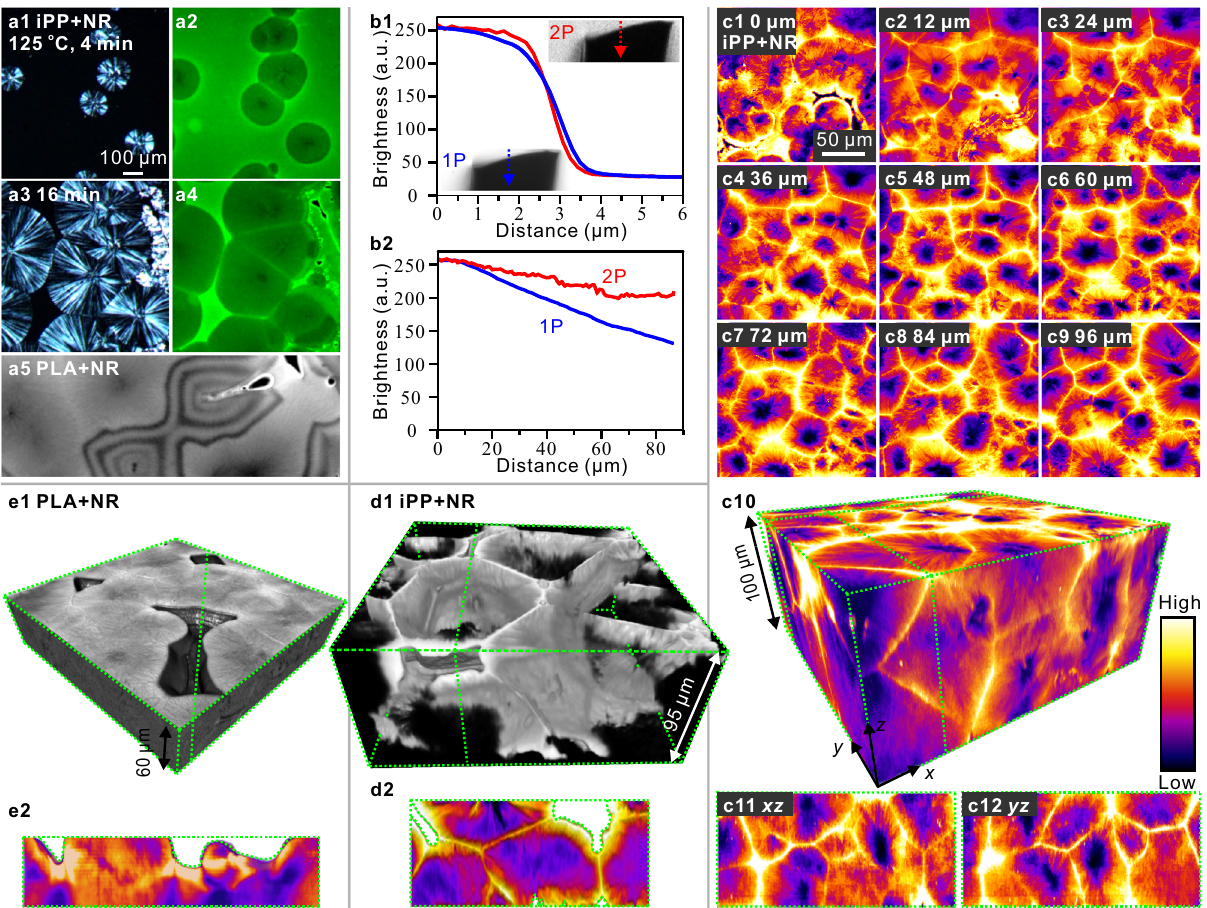
Fig. 1 2D and 3D fl uorescence microscopy of fl uorophore-labeled polymers after complete isothermal crystallization showing internal and surface structure. a1 - a4 , 2D micrographs of ∼ 10 µ m thick fi lm of iPP doped with 0.05 wt % Nile Red during isothermal crystallization at 125 °C: ( a1 , a3 ) cross- polarized and ( a2 , a4 ) FM; the dye is seen to be partially rejected from the growing spherulites. a5 FM of fully crystallized PLA; cavitation and Newton interference contours are seen. b Comparison of 1-photon and 2-photon confocal microscopies: (b1) z- scans across a sharp end of a glass fi ber embedded in NR-doped polystyrene (PS) — blue = 1-photon, red = 2-photon; (b2) 1-photon (blue), and 2-photon (red) fl uorescence intensity vs . depth in a sheet of NR-doped PS illuminated by 543 nm and 1000 nm lasers, respectively. c NR-labeled iPP crystallized at 120 °C: ( c1 – c9 ) selected z- slices as recorded by 2-photon microscopy, bottom to top, using false-color scale at the bottom right; (c10) 3D solid reconstructed therefrom (see Supplementary Video 1); (c11,c12) vertical ( xz and yz ) slices along dashed lines in c10. d Labeling by in fi ltration: neat iPP was crystallized at 130 °C and subsequently immersed in NR/p-xylene solution; (d1) “ porous ” 3D rendering; (d2) vertical section along the dotted line in d1 . e NR-doped PLA crystallized at 120 °C showing surface cracks ( cf . 2D image in a5 ); ( e1 ) gray scale solid (bright = high fl uorescence, black = 0); ( e2 ) vertical slice along dashed line in ( e1 ). Exceptionally, the crack areas (zero fl uorescence) in ( d2 ) and ( e2 ) are